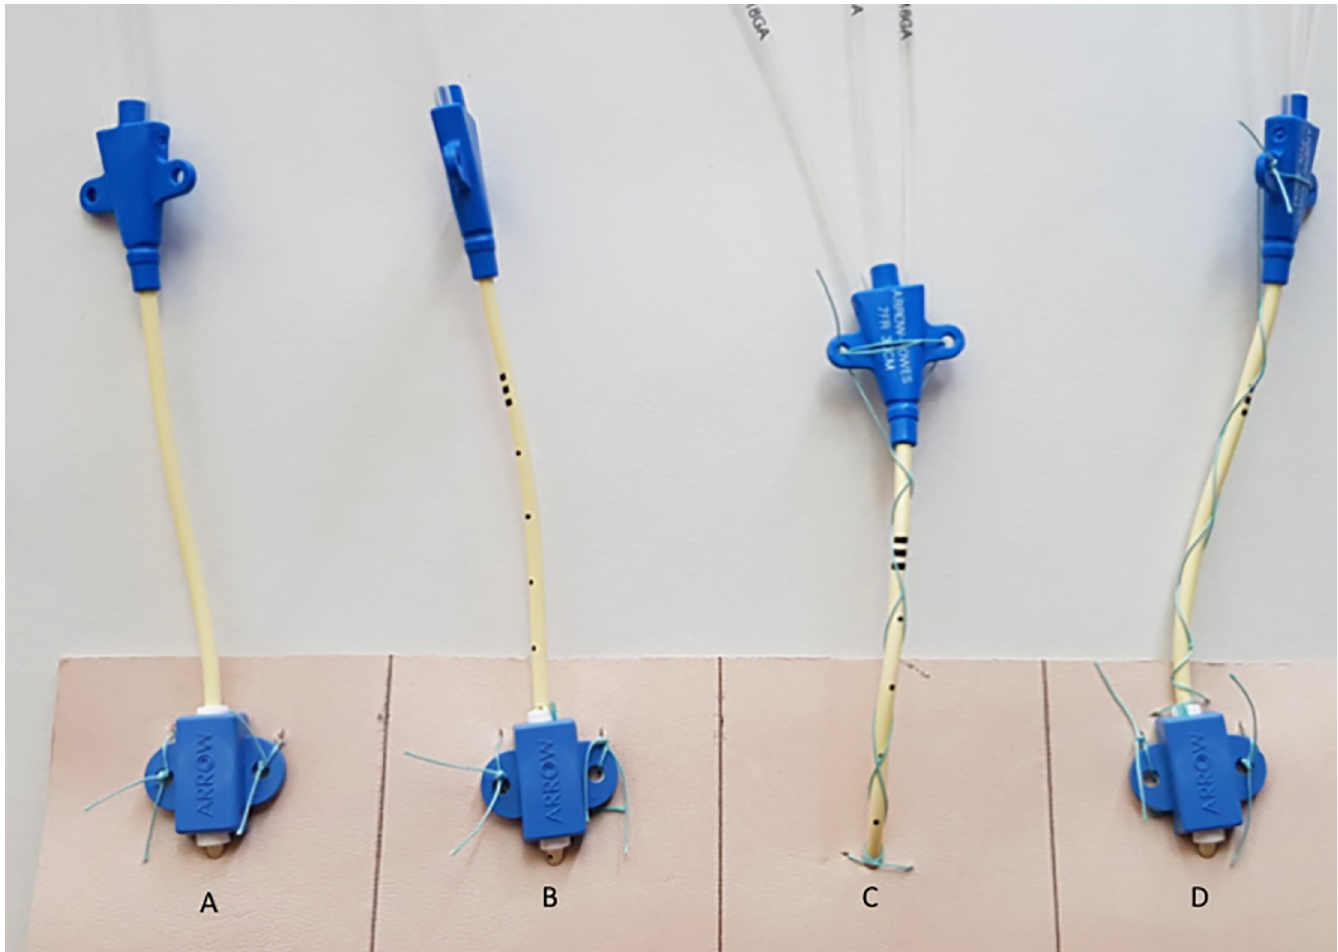
Fig 1. Fixation techniques. From the left to the right, the four fixation techniques used in the present study are presented (A-D). A represents the “standard” technique, B represents the “compression” technique, C represents the “finger trap” technique and D represents the “complete” technique. Details of the compression technique are presented in Fig